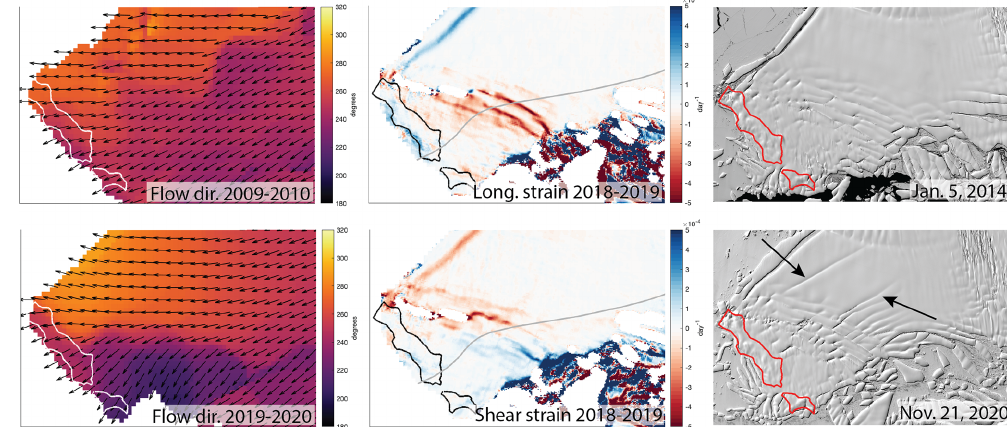
Figure 9. Detail of the shear zone upstream of the TEIS pinning point showing the evolution of key features over time. First column: 2-year averages of flow direction, showing a split in flow direction around the pinning point that had not clearly developed by the 2009–2010 image, but had become very distinct by 2019–2020 image. Second column: longitudinal and shear strain rates derived from Sentinel-1 imagery showing distinct bands of high strain rates in the pinning point shear zone. Grey line is Flowline B (Fig. 1). Third column: Landsat-8 images showing the development of large rifts and smaller fractures nucleating in the pinning point shear zone. Red outline in all panels is the grounded pinning point from the 2011 MEaSUREs dataset (Rignot et al., 2016). Subset region is indicated in Fig.